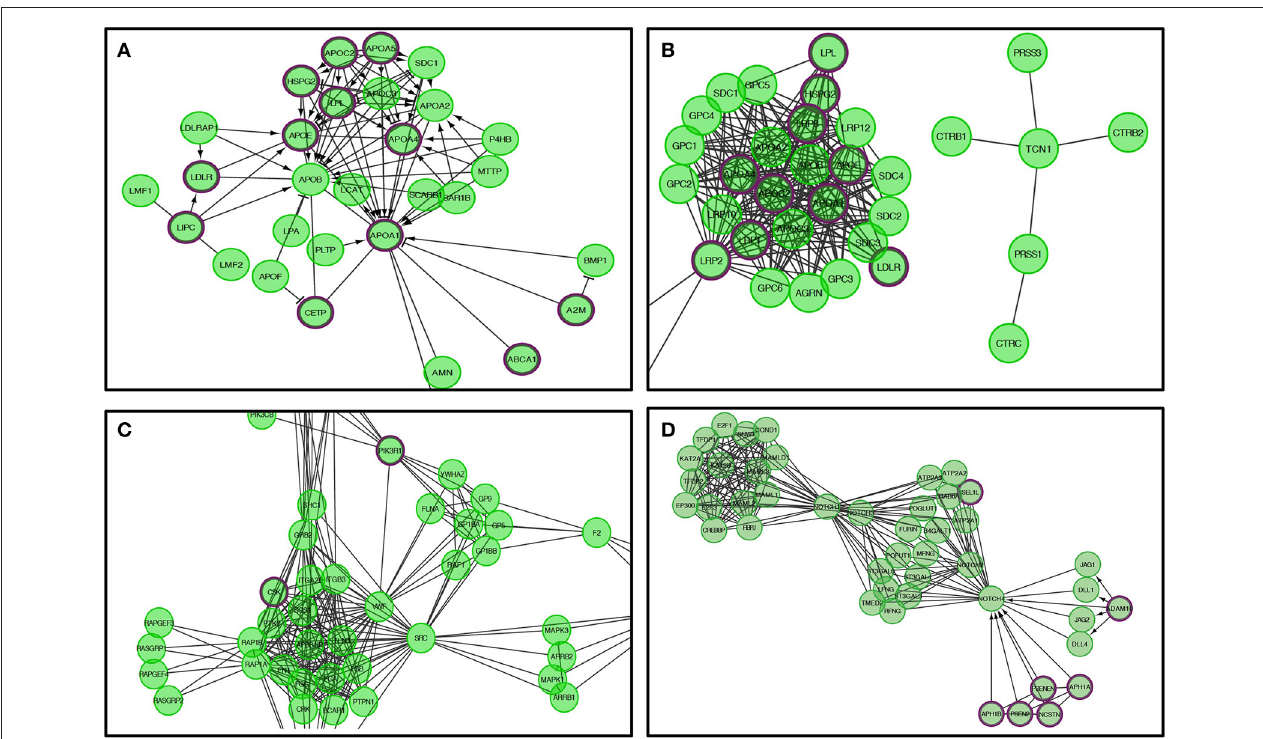
FIGURE 6 | The Reactome pathways displayed in Figure 5 were converted into a functional interaction network using FI network view. Sub-pathways within the original pathway diagrams were extracted into the FI network as well. Hit genes are displayed in a thick purple border in the FI network view for a hit pathway. (A) Lipid digestions, mobilization, and transport. (B) Metabolism of vitamins and cofactors. (C) Platelet activation, signaling, and aggregation. (D) Signaling by